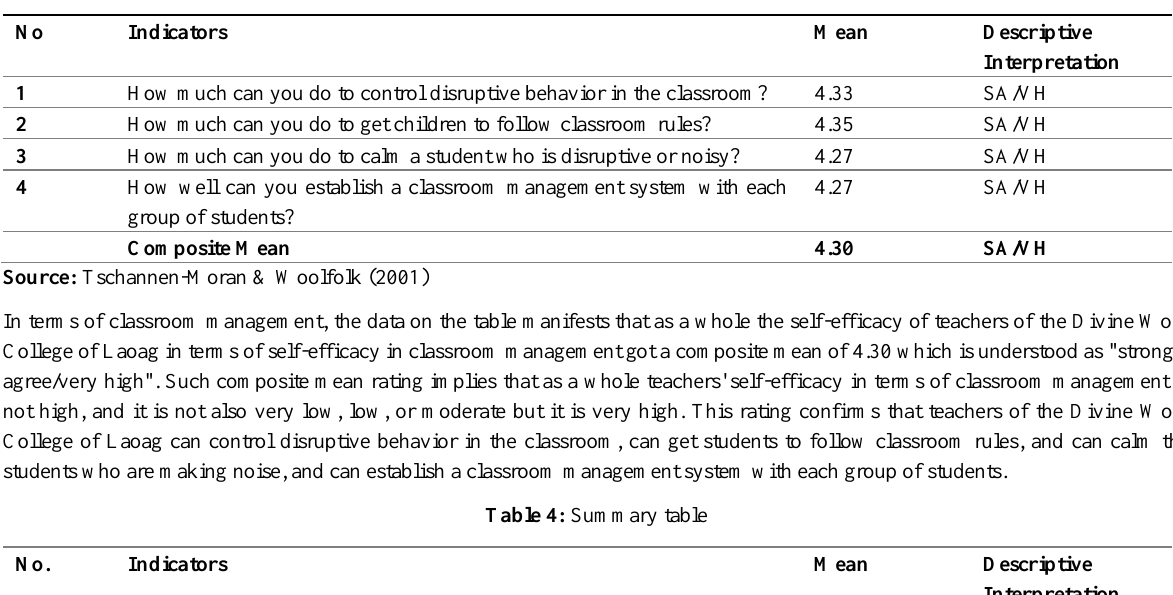
Table 3: Self-Efficacy in Classroom Management